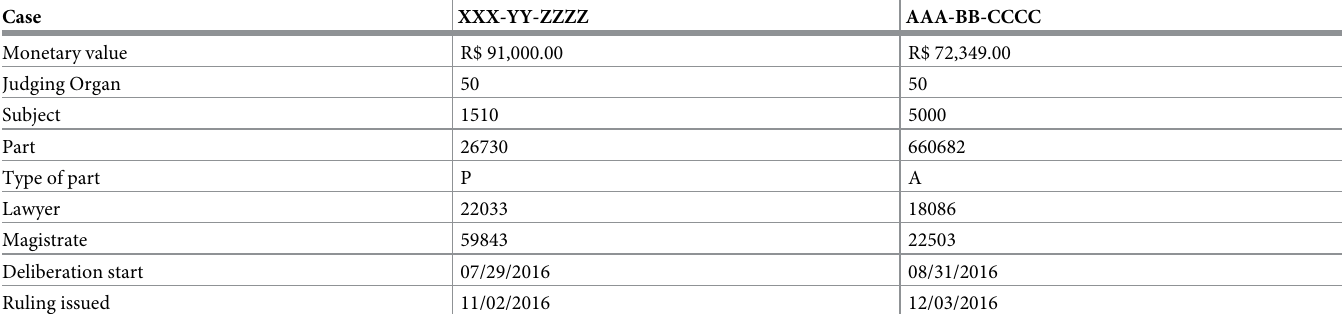
Table 1. Two cases and their corresponding information in the database. The data were modified to anonymize their content.